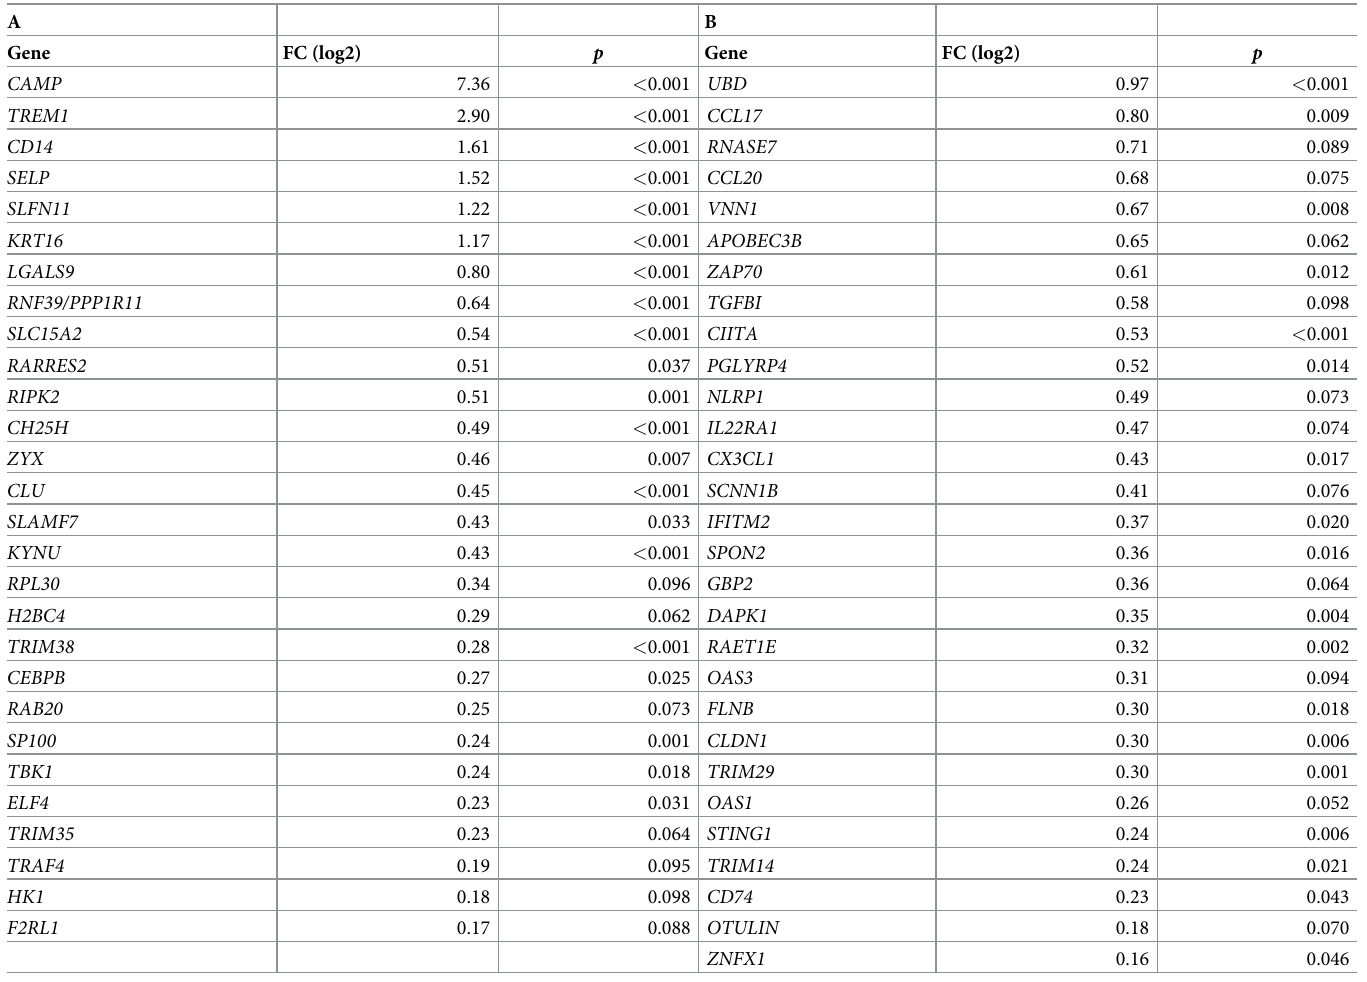
Table 1. Effect of calcitriol treatment on hAEC antimicrobial protein gene